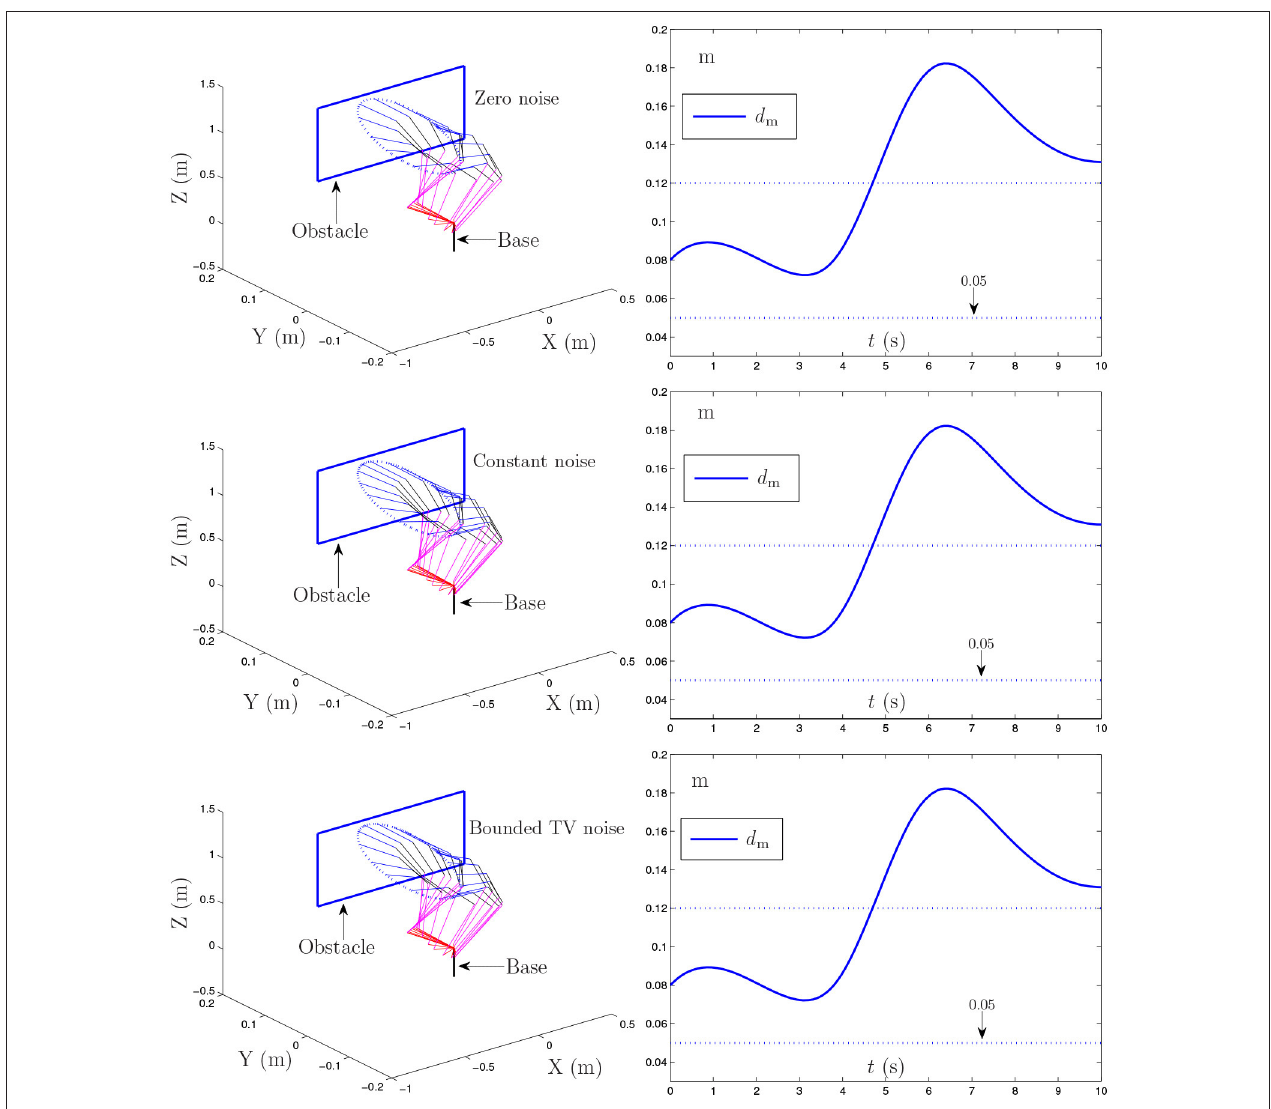
FIGURE 7 | Simulation results synthesized by the proposed NTOA scheme (6) for the PA10 end-effector tracking the circular path, where the zero noise, constant noise, and bounded time-varying (TV) noise are